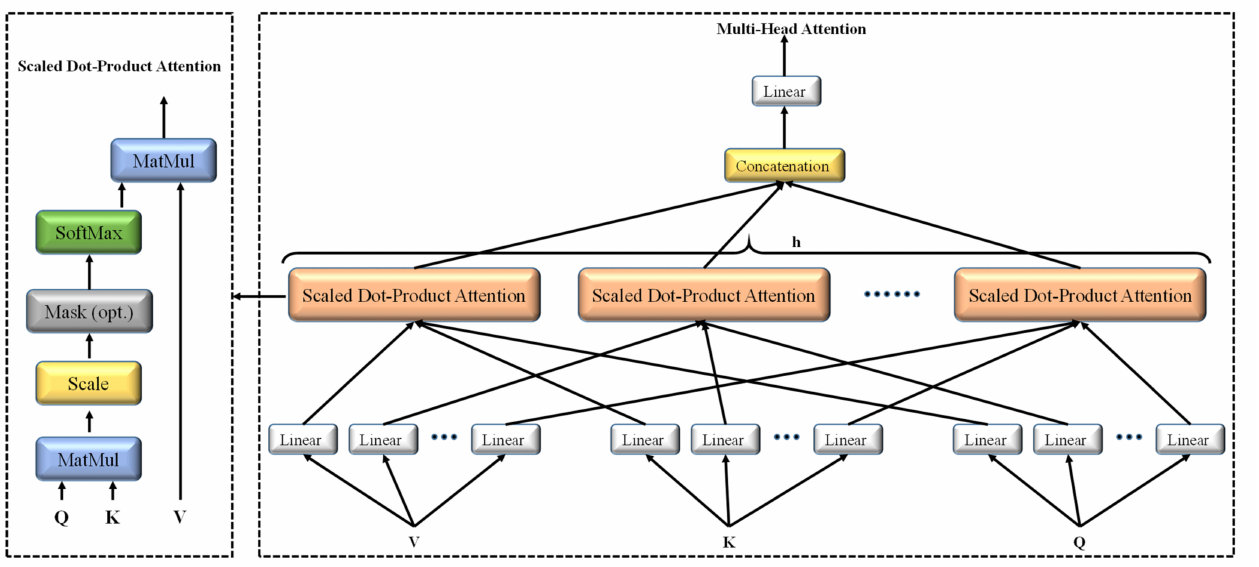
Figure 4. Scaled dot-product-based multihead attention mechanism.